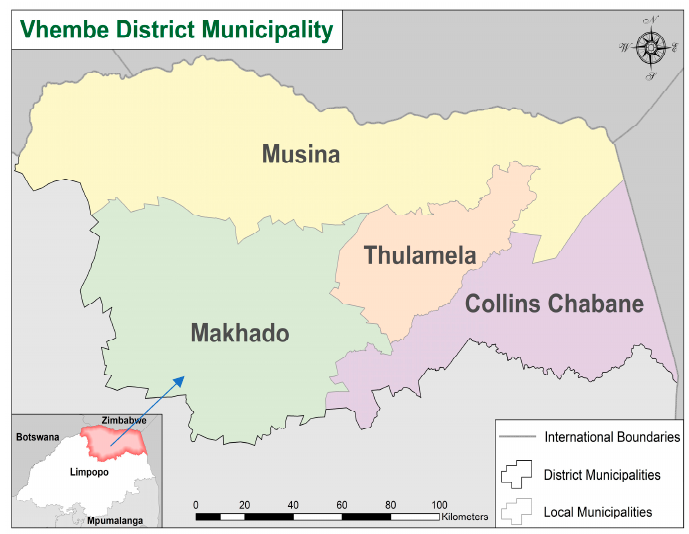
Figure 1. Maps of Vhembe District Municipality, Limpopo Province. Source: